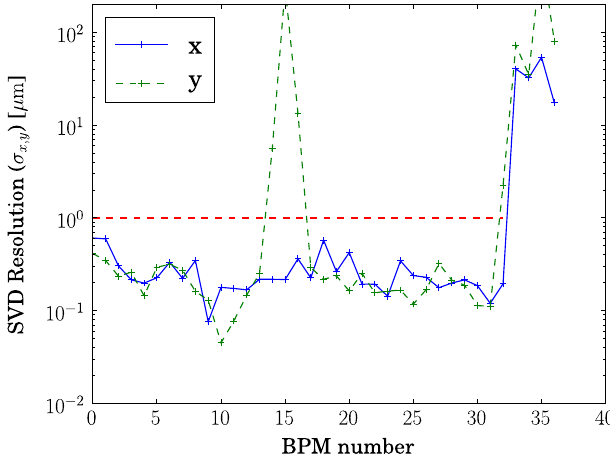
2010.FIG. 16. Example of resolution determination using an SVD based MIA: x (top left) and y (top right) positions measured by the BPM in question, and their distributions (bottom left), x and y residuals (bottom